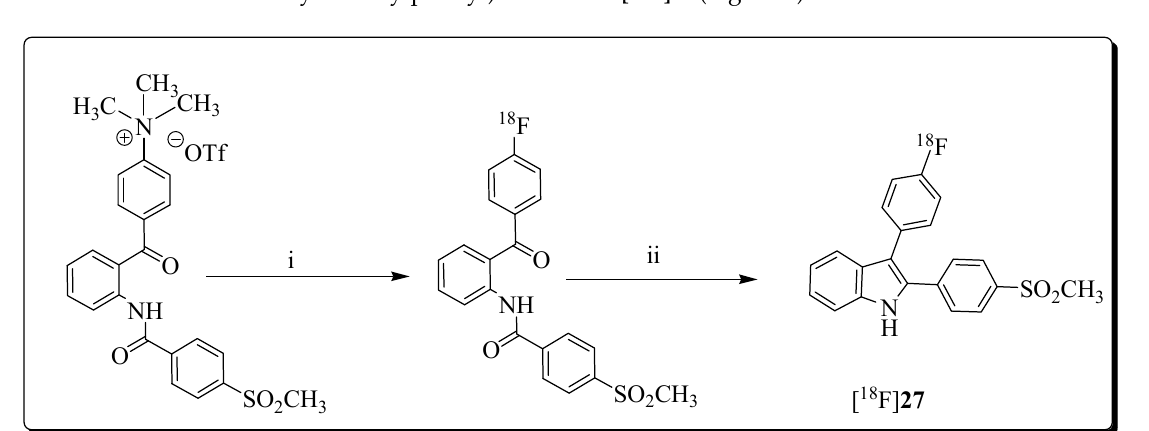
Figure 4. Radiosynthesis of [ 18 F] 27 via McMurry coupling. Reagents: (i) [ 18 F]fluoride, K 222 /K 2 CO 3 , DMF; (ii) TiCl 4 , Zn, THF.